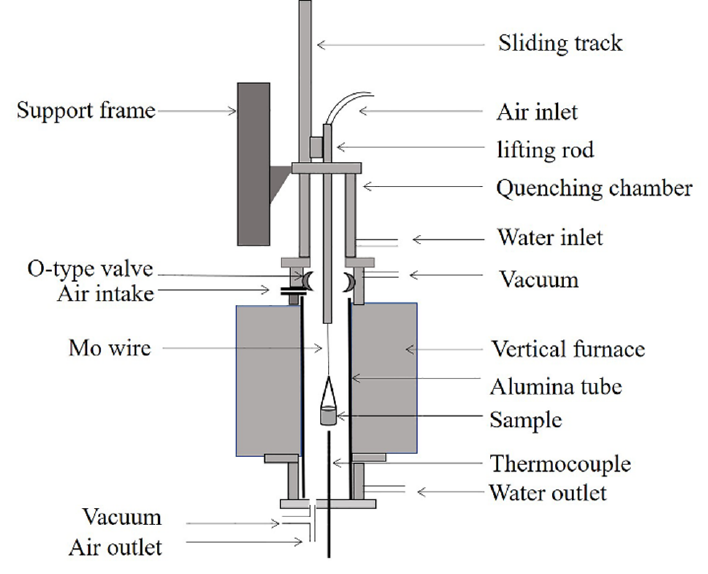
Figure 1. Vertical reaction furnace with automatic sample lifting device. After the sample was placed, the gas tightness of the reaction chamber, which was constituted by the quench chamber and alumina tube was checked by vacuuming and backfilling argon gas for three times. Argon is used to protect the composition of molten steel from oxidation by oxygen during the whole experiment. The flow rate of argon (purity 99.999%) was 200